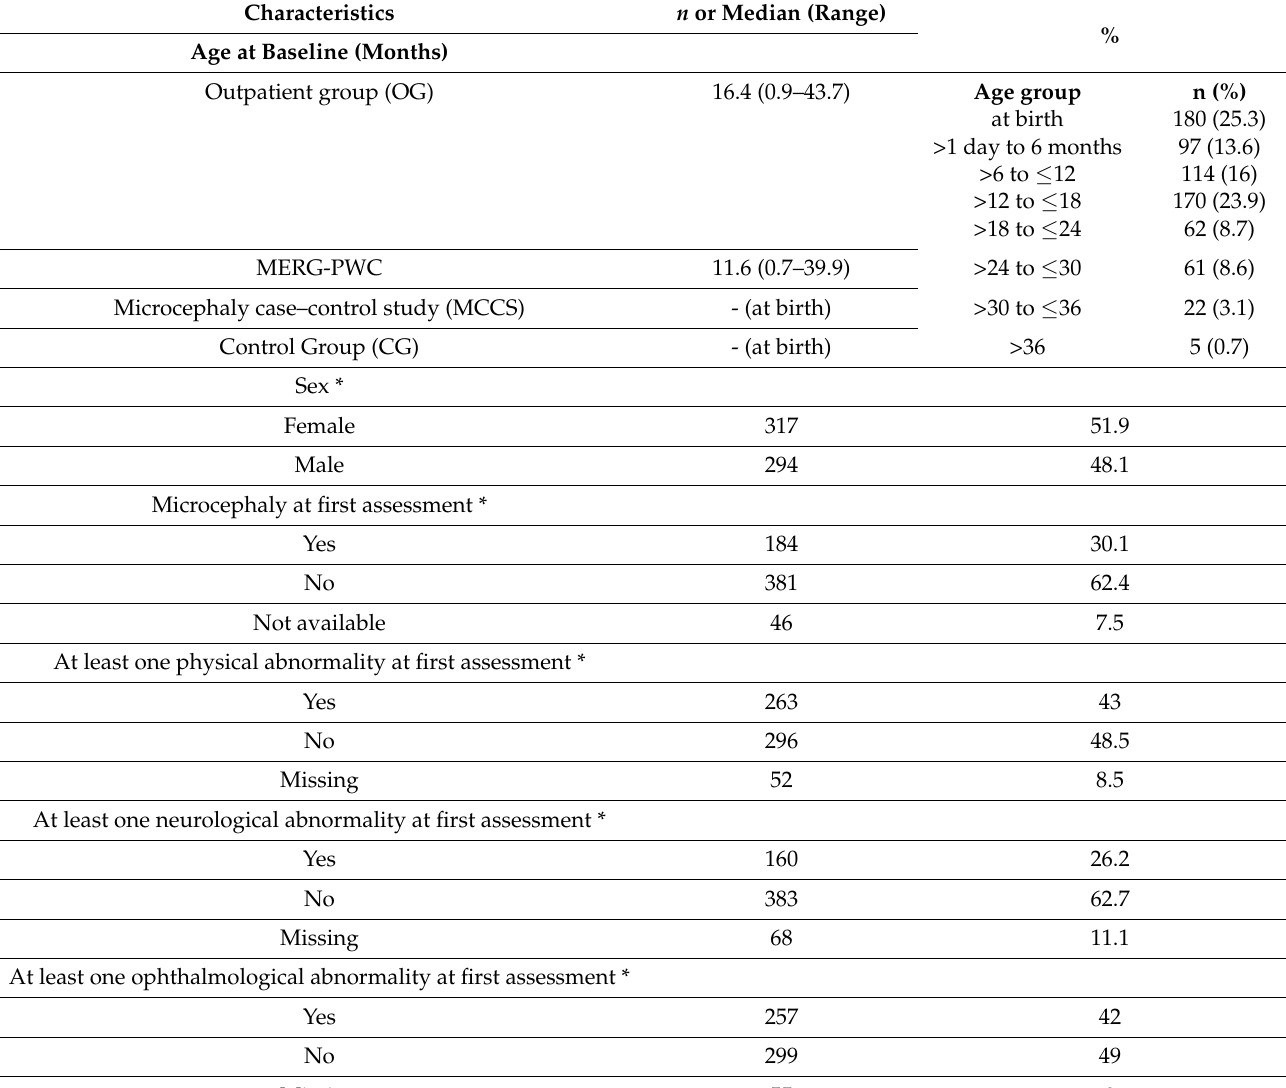
Table 4. Baseline cohort